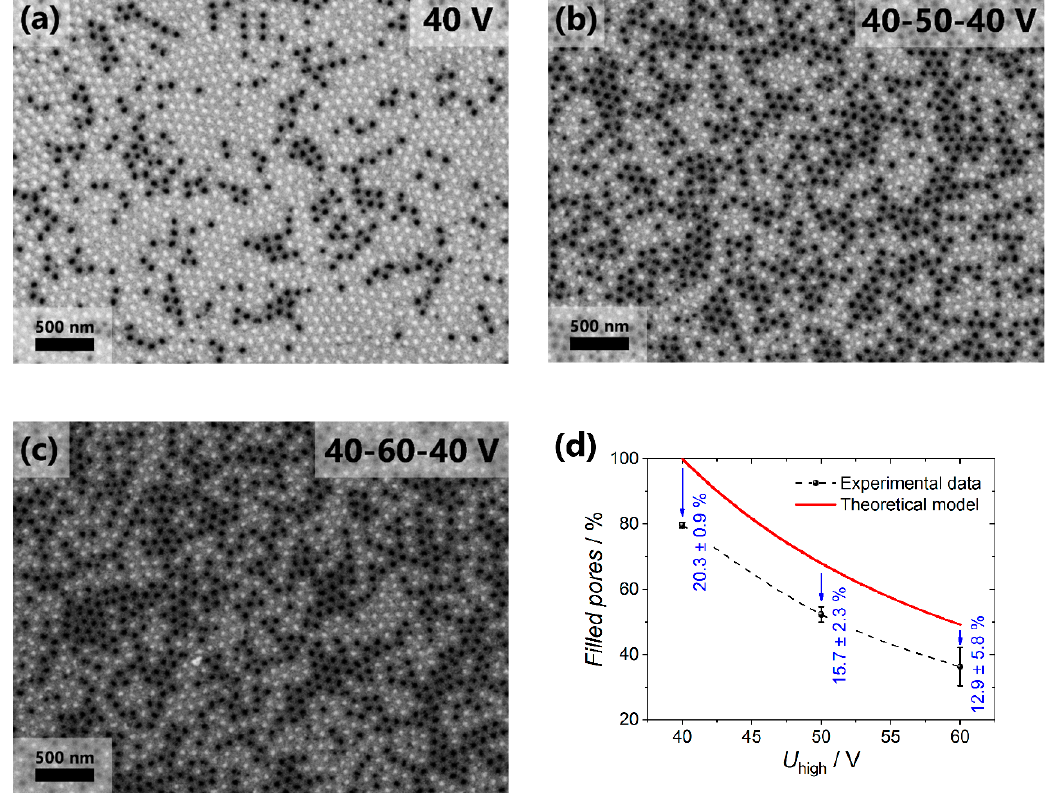
Figure 3. SEM images of the Au / AAO nanocomposites surface after selective dissolution of copper current collector: ( a ) Sample s40 without the blocking layer; ( b ) sample s50 with the blocking layer formed at 50 V; ( c ) sample s60 with the blocking layer formed at 60 V. Panel ( d ) demonstrates the comparison of the fraction of the filled pores with predictions according to Equation 1 as a function of the anodization voltage applied during the blocking layer formation.